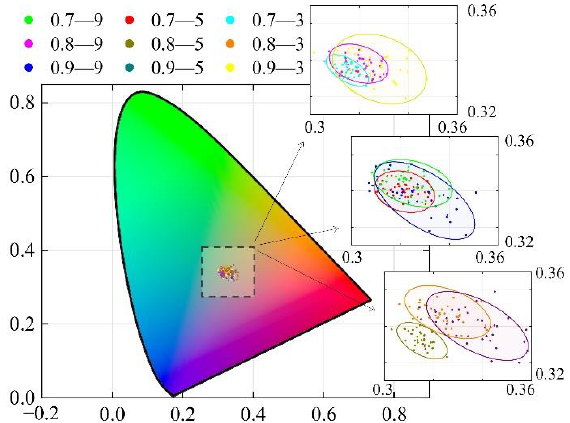
Figure 9. Color coordinates distribution diagram.